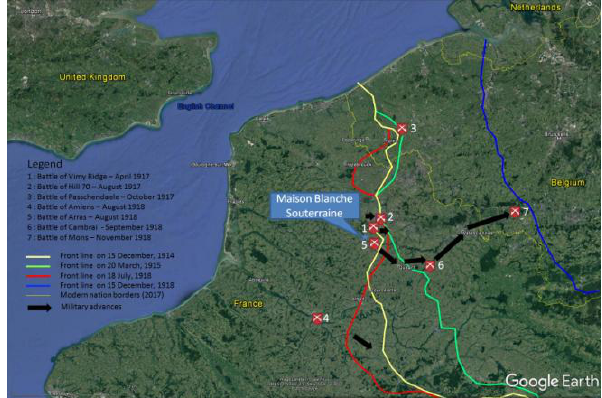
Figure 1. The western front in 1914-1918 with Canadian battles and the position of the Maison Blanche souterraine relative to these battle sites, adapted from Hayes and Iarocci